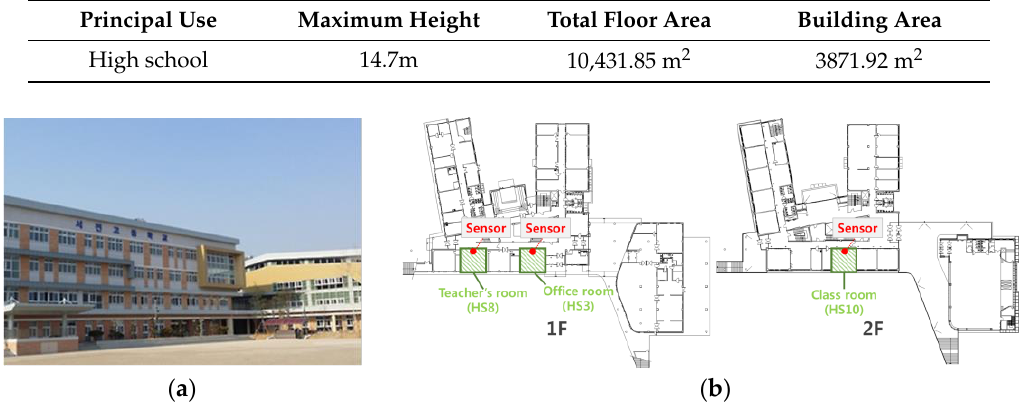
Table 1. Building details.